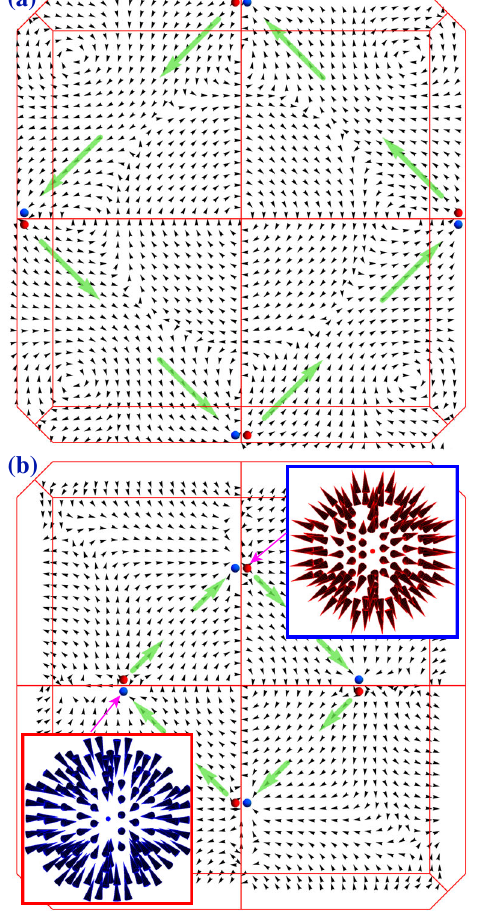
FIG. 3. Berry curvature from pairs of Weyl points. (a) The distribution of the Berry curvature for the k z ¼ 0 plane, where the blue and red dots denote the Weyl points with chirality of þ 1 and − 1 , respectively; (b) same as (a) but for the k The insets show the 3D view of hedgehoglike Berry curvature near the two selected Weyl points.